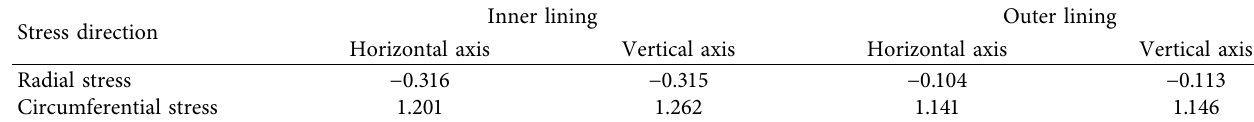
Figure 15: Radial stress (a) and circumferential stress of inner lining (b) (Pa). Table 4: Results of finite element calculation